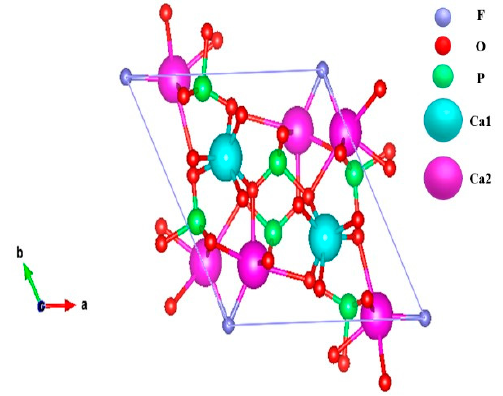
Figure 2. Projection of apatite molecular structure perpendicular to c axis (purple, red, green, blue, pink spheres refer to F, O, P, Ca1, Ca2, respectively).